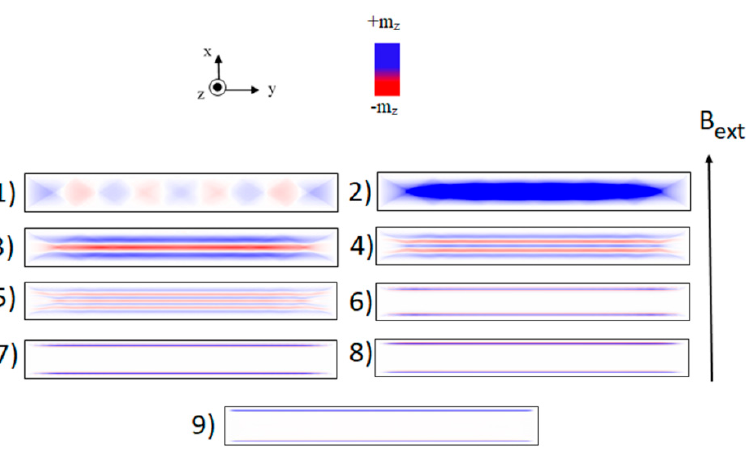
Figure 4. Snapshots of the FMR modes found in the simulated FMR spectra shown in Figure 1b. Blue/white/red colors represent the m z component.